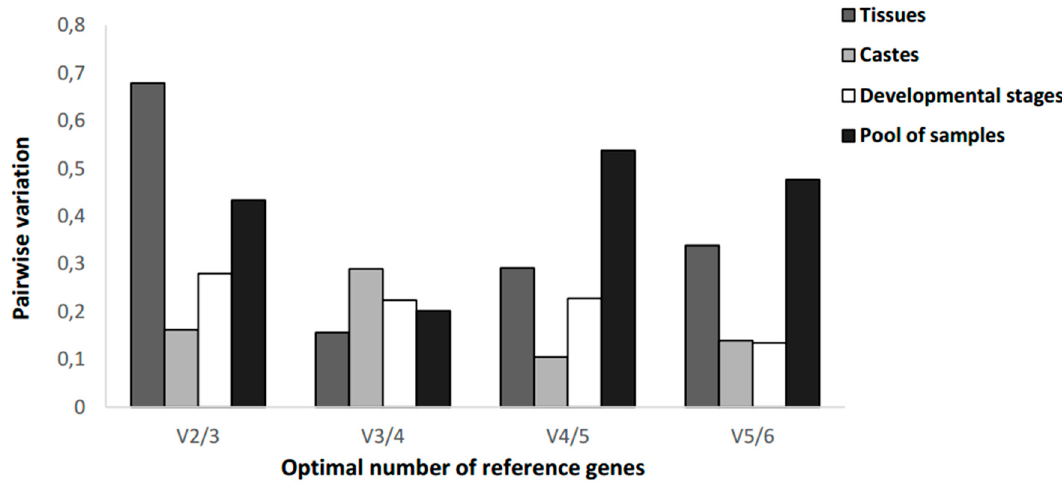
Figure 2. Pairwise ( V ) variation calculated by geNorm to determine the optimal number of reference genes. For gene expression analysis in different tissues (forager head, larval midgut and forager midgut), the pairwise variation value for V 3/4 was the lowest (0.156), indicating that the combination